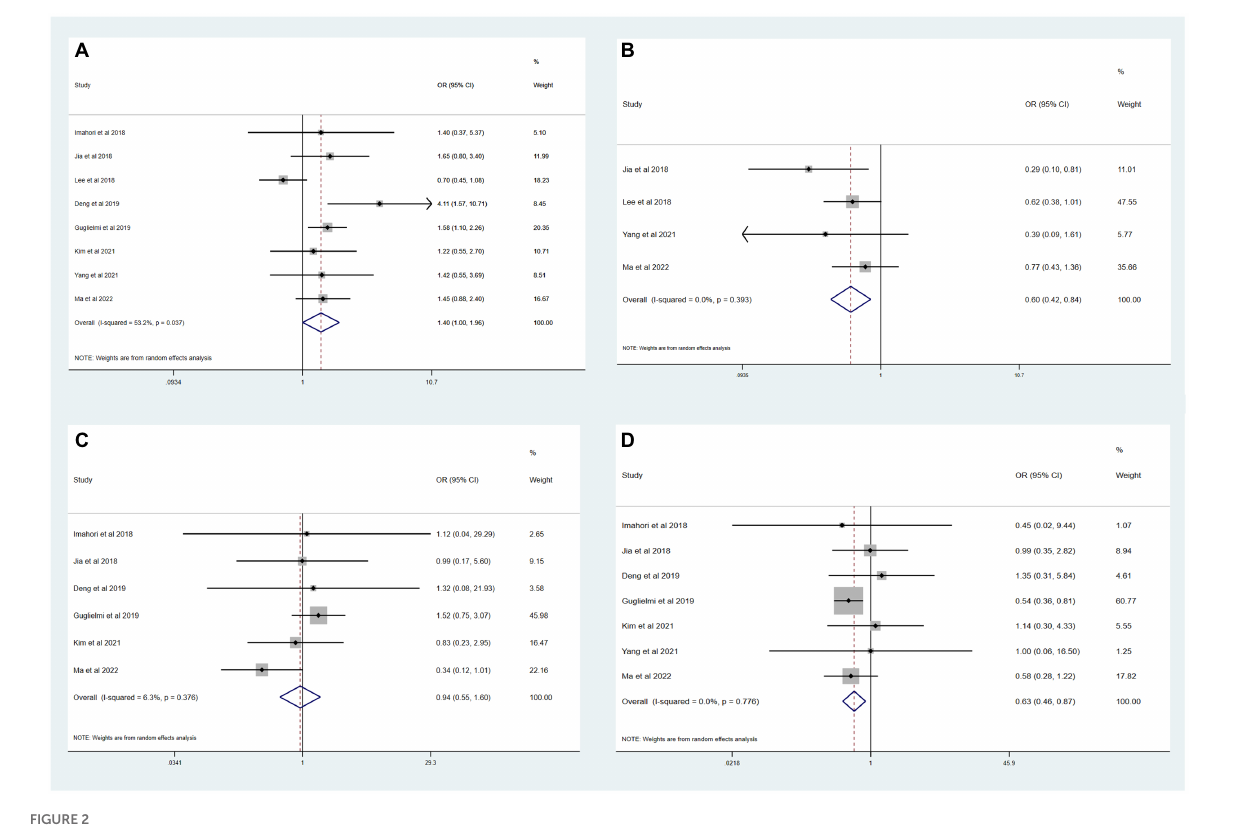
FIGURE 2 Meta-analysis of etiology impact on thrombectomy outcomes. (A) Favorable functional outcome. (B) ICH. (C) sICH. (D)